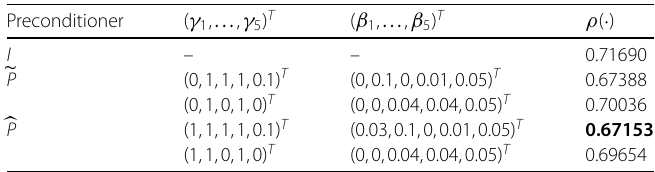
Table 2 ρ ( G –1 F ), ρ ( (cid:9) G –1 (cid:9) F ), and ρ ( (cid:16) G –1 (cid:16) F ) with α = 0.1 and ω i = 0.9